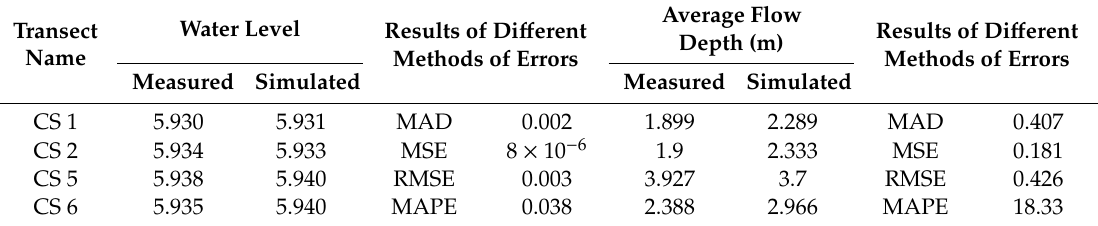
Figure 11. Comparison of measured and simulated bed elevations at CS 1, CS 2, CS 5, and CS 6. Table 5. Comparisons of water level and average flow depth.